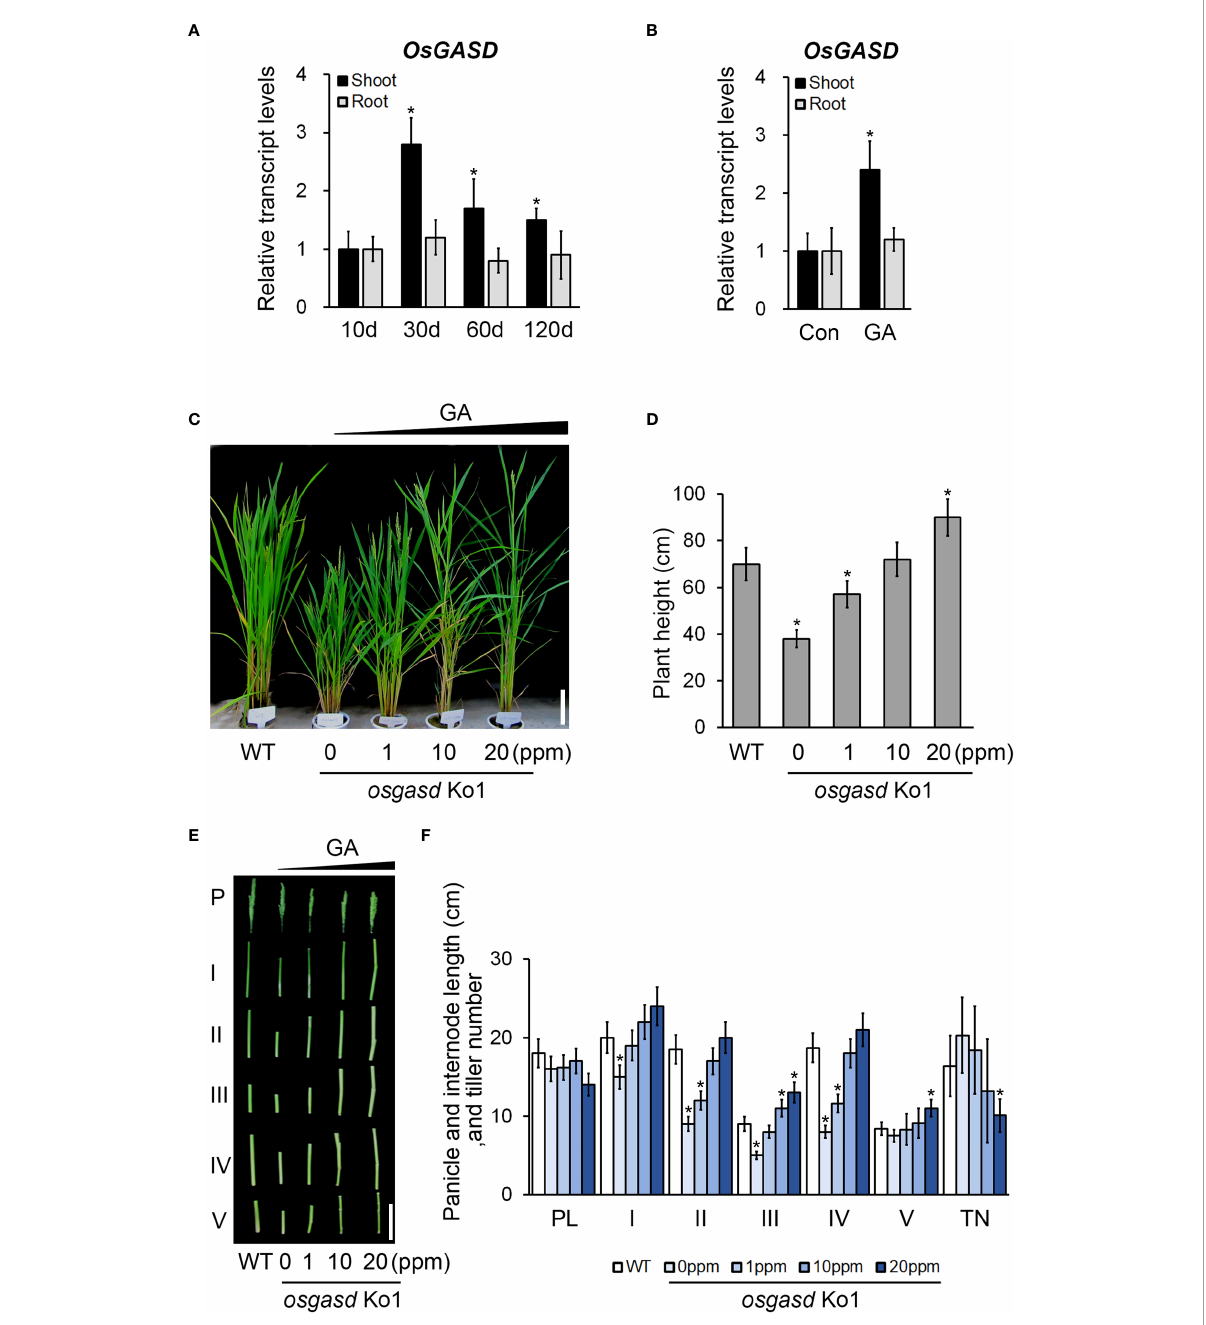
FIGURE 2 Analysis of OsGASD expression and effect of osgasd knockout mutant morphology in response to GA. (A) RT-qPCR analysis shows expression patterns of OsGASD in shoot and root. (B) The transcript level of OsGASD is shown in response to GA. Ten-day-old wild-type seedlings (Dongjin) were treated with 100 µM GA3 for 15min. Control plants were not treated with GA (Con). Error bars indicate SD. OsActin1 (Os03g0718100) was used as an internal control and relative expression levels are shown in fold values. Asterisks indicate statistically signi fi cant differences between the corresponding samples and their control (p-value<0.1, Student ’ s t-test). (C-F) Growth of osgasd knockout mutant grown on green house. (C and D) At the panicle heading stage (14 weeks) of osgasd knockout mutant treated with the indicated concentration of GA for 1, 10, 20 mg/L (ppm) (C) GA 3 solution were sprayed with distilled water as control. Scale bar=15cm (D) Plant height measured seven days later for analysis. (E, F) P and PL indicated the panicle and panicle length. I to V indicated the corresponding internodes from top to bottom. Scale bar=10cm (E) . Quanti fi cation of plant height (D) , panicle and internodes length, and tiller number (F) in osgasd knockout mutant treated with GA (n>20). WT plants did not treat with GA. Error bars indicate SD. Asterisks indicate statistically signi fi cant differences between the corresponding samples and their control (p-value<0.1, Student ’ s